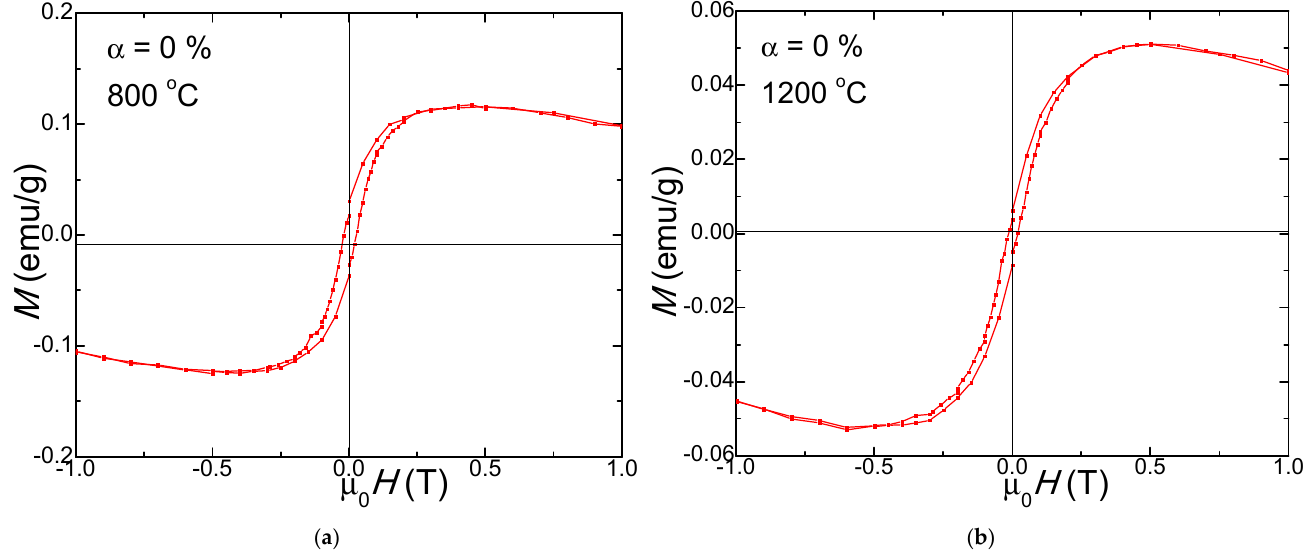
Figure 7. Magnetic hysteresis loops of SiO 2 matrix ( α = 0%) annealed at 800 °C (a) and 1200 °C (b).